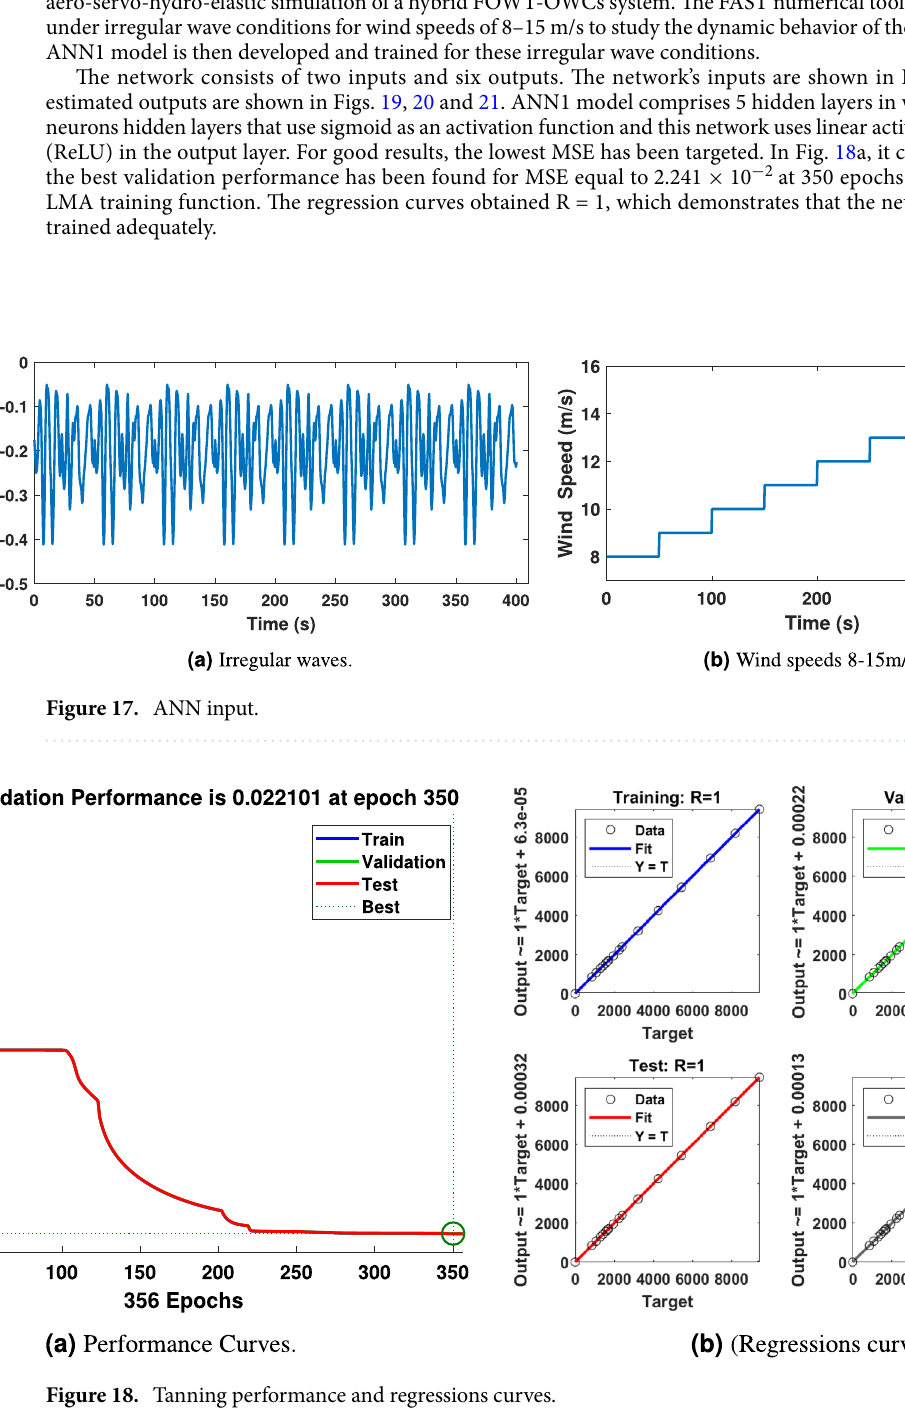
Figure 18. Tanning performance and regressions